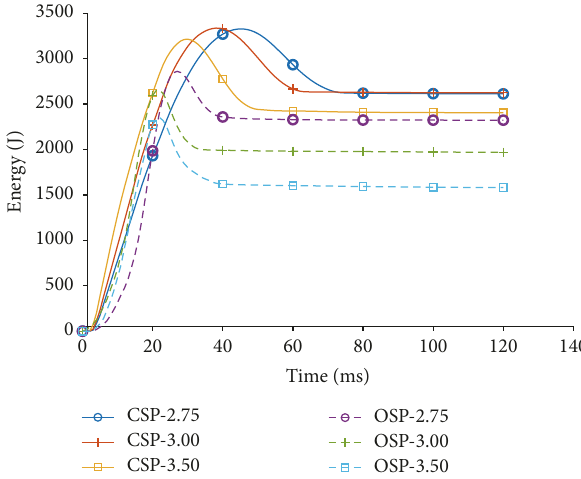
Figure 7: The time history curves of the total energy of CSP/OSP specimen when V � 4m/s.